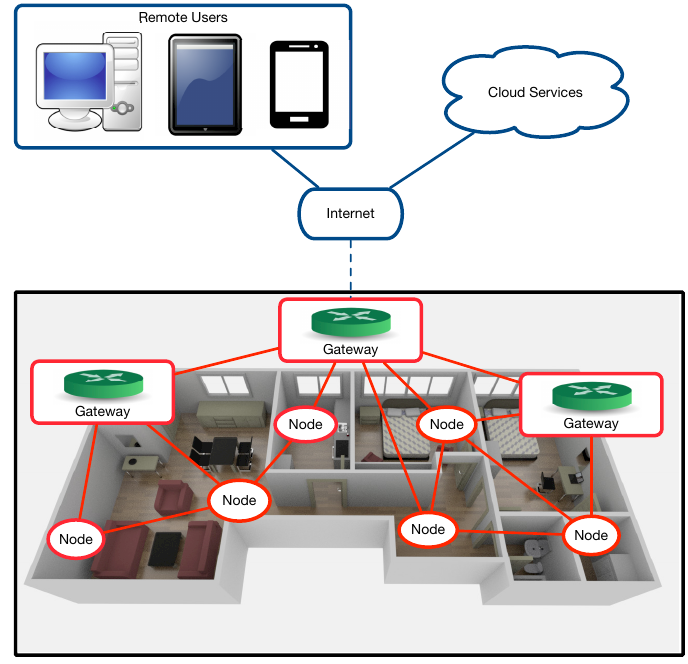
Figure 3. General view of ZiWi’s communications